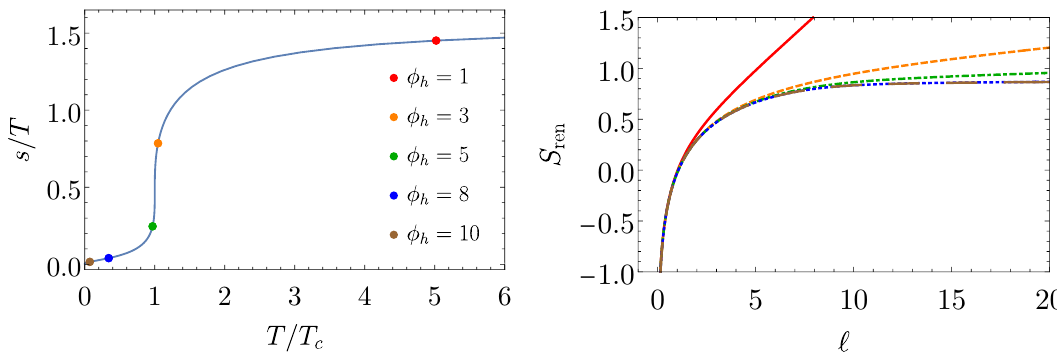
Figure 9 . Left panel: entropy density over temperature for second order phase transition ( α = 0 . 16 ). Dots: horizon value of scalar field, φ h = 1 , 3 , 5 , 8 , 10 . Right panel: EE computed using (5.16) for different black brane solutions as function interval ‘ . Colors correspond to solutions marked with points in left panel.